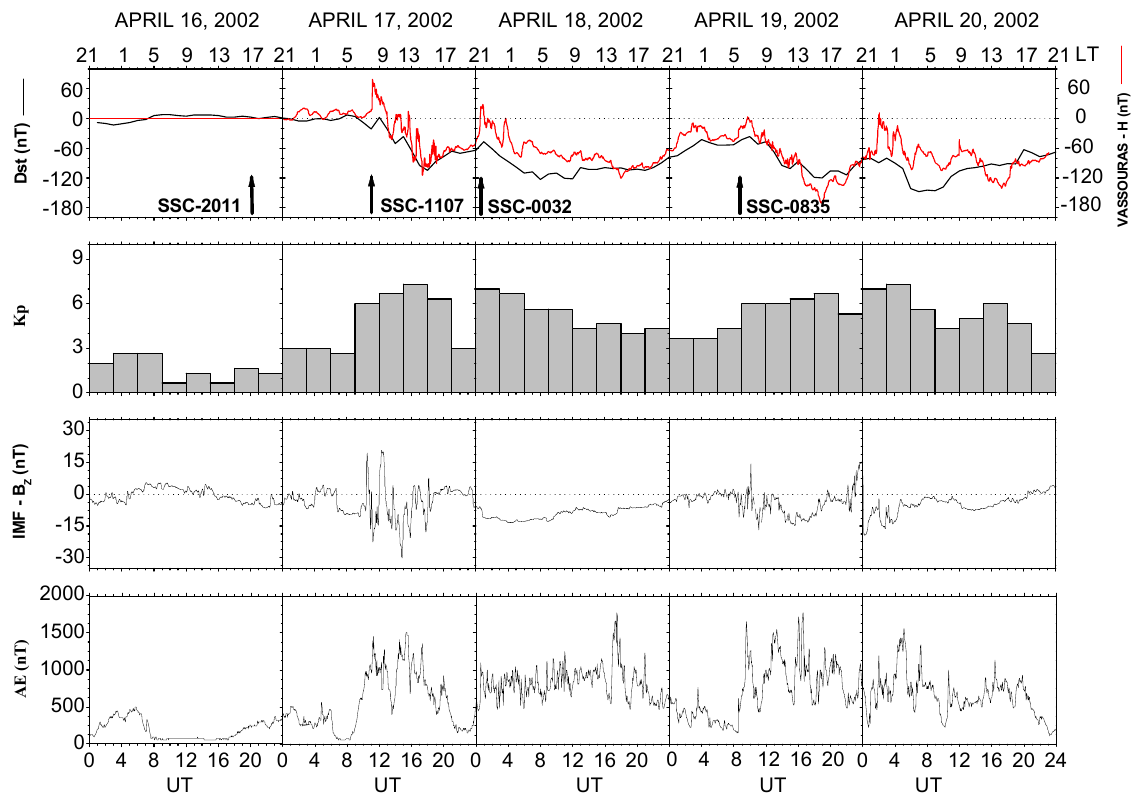
Fig. 2. The variations of the K p , D st , AE geomagnetic indices and of the IMF B z component, during the period 16–20 April 2002. Also, the geomagnetic H -component variations observed during the period 16–20 April 2002 at Vassouras, Brazil, are shown with the D st index variations. Table 1. Details of geomagnetic activity during the period 17–20 April